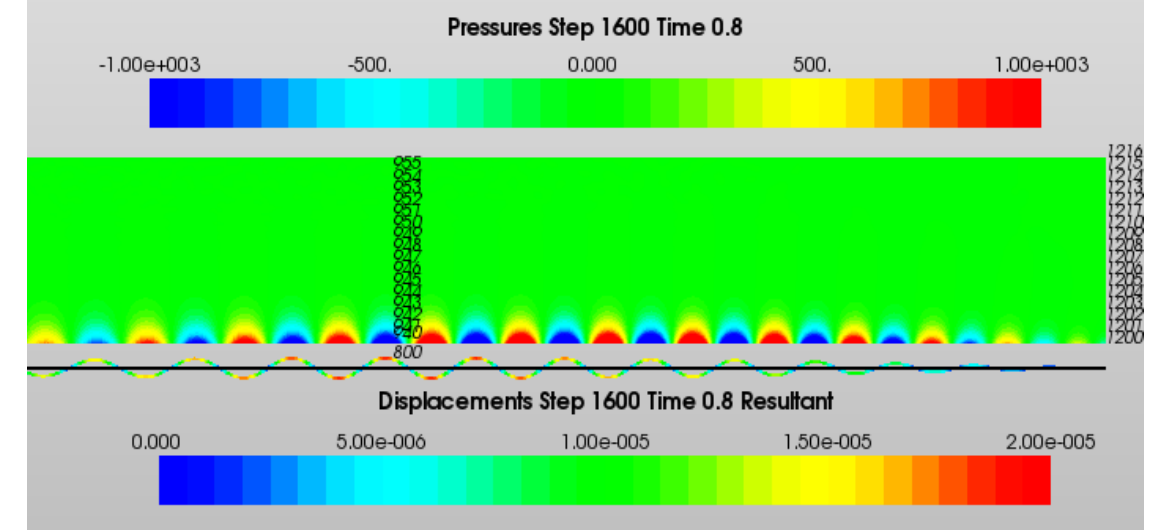
Figure 7. A second snapshot at 0.8 s also shows the numbered nodes at the edge of the model at a 256 m radius.